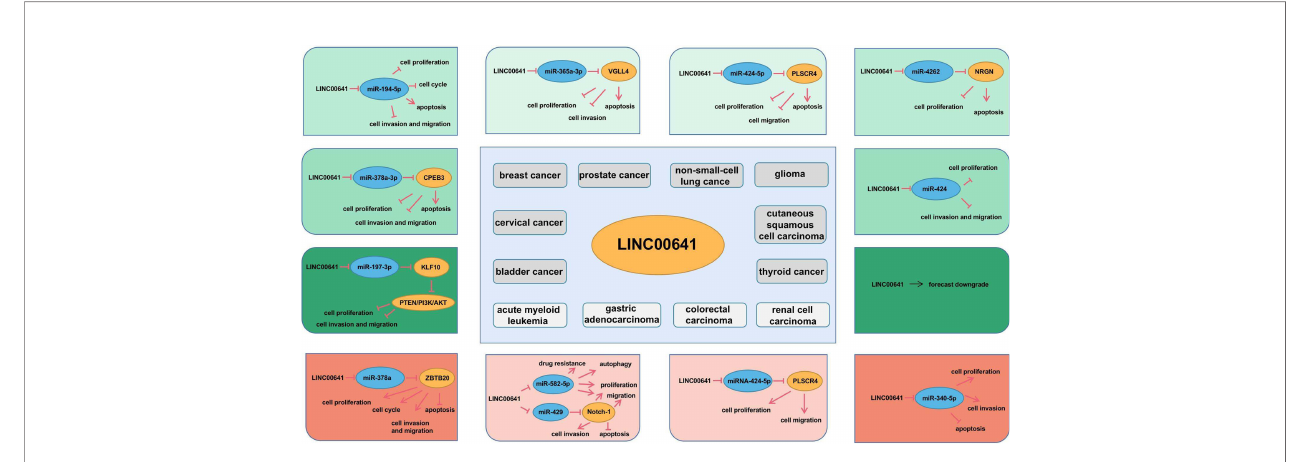
FIGURE 4 | Molecular mechanism of LINC00641 in different human